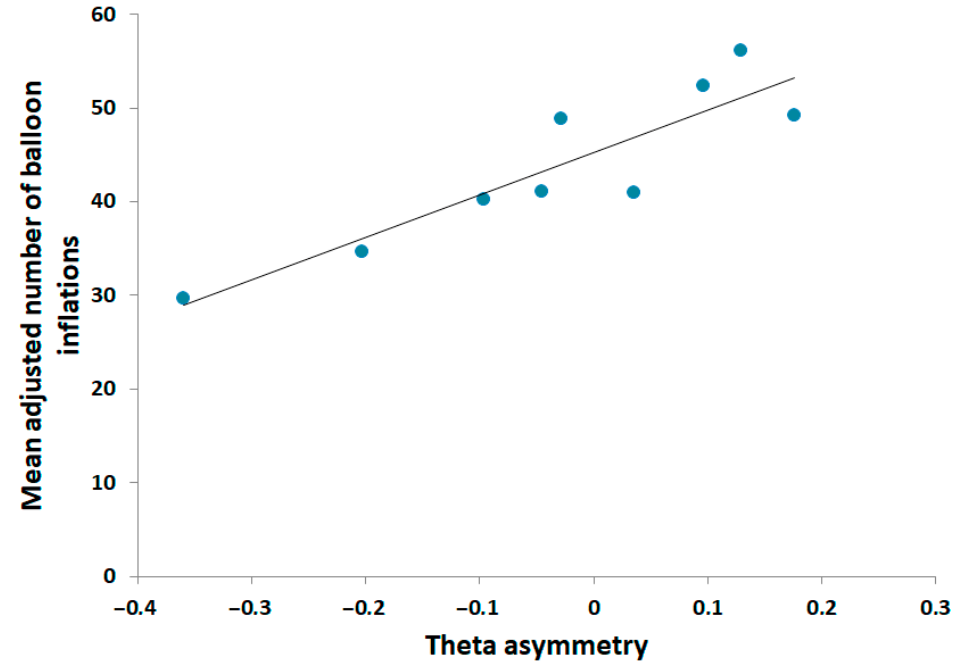
Figure 3. Scatterplot of the relationship between the mean adjusted number of pumps and resting state theta asymmetry in favorable